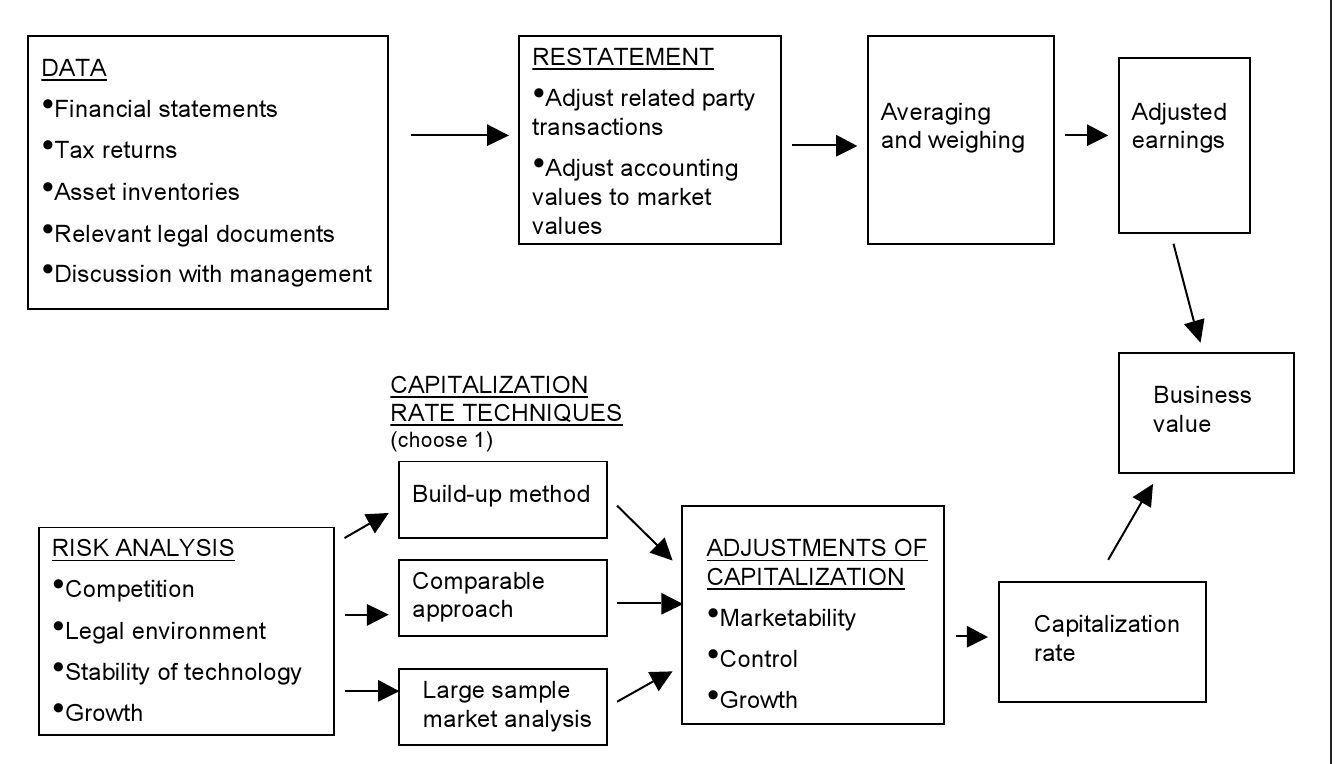
Figure 1. Valuation Process Used With the Earnings Capitalization